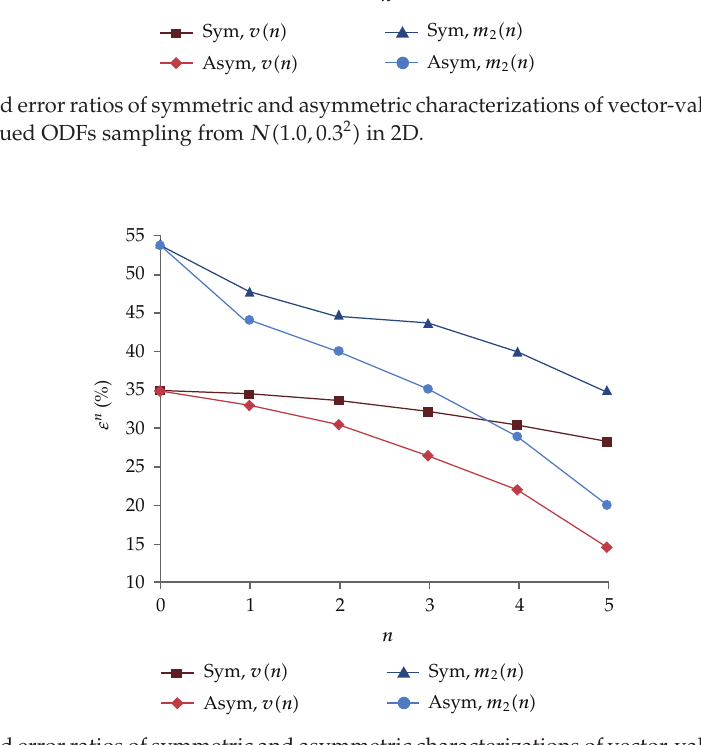
Figure 6: Squared error ratios of symmetric and asymmetric characterizations of vector-valued and second- order tensor-valued ODFs sampling from N (cid:3) 1 . 0 , 0 . 3 2 (cid:4) in